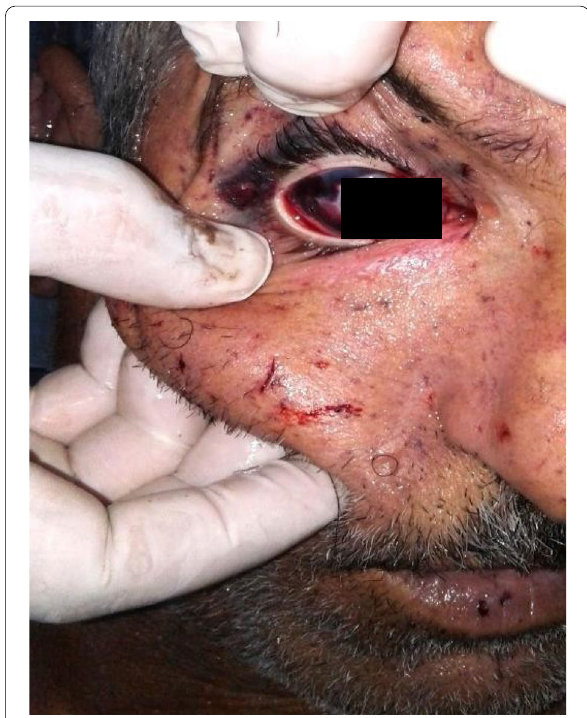
Fig. 2 Right periorbital haematoma associated with petechial subconjunctival